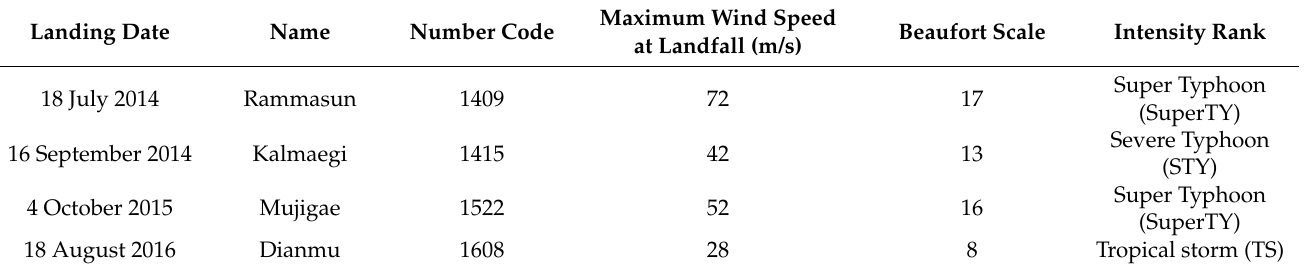
Table 1. Appearance situation of tropical cyclones on the Leizhou Peninsula from 2014 to 2017.